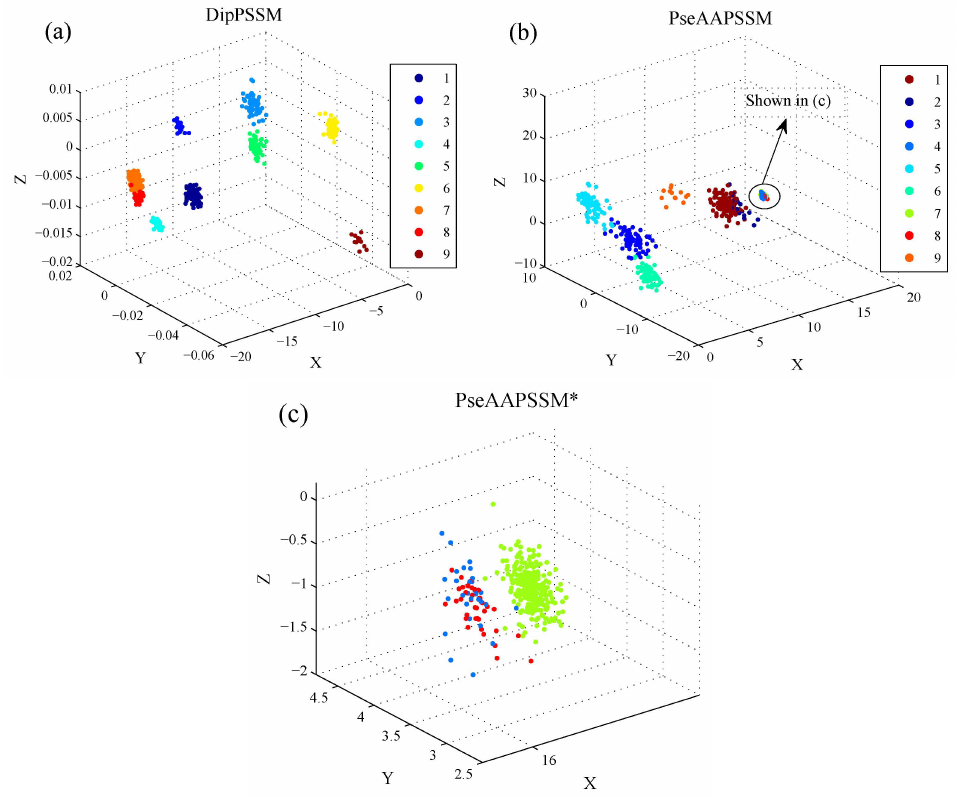
Figure 4. 3D scatter on Dataset 1 with X-, Y- and Z-axes representing the first three components of LDA, respectively: ( a ) DipPSSM; ( b ) PseAAPSSM and ( c ) the patch of high resolution for the indicated region in ( b ).